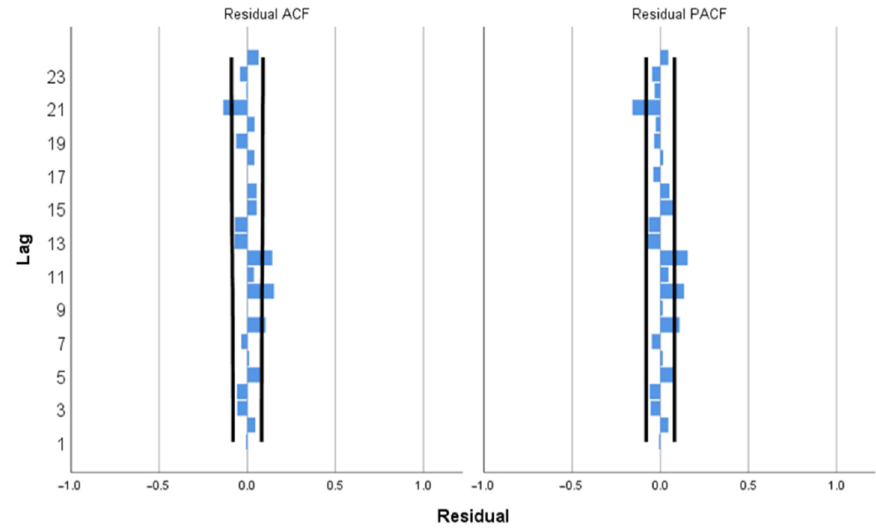
Figure 2. ACF and PACF residuals for SARIMA (1,2,1) (2,0,0) .